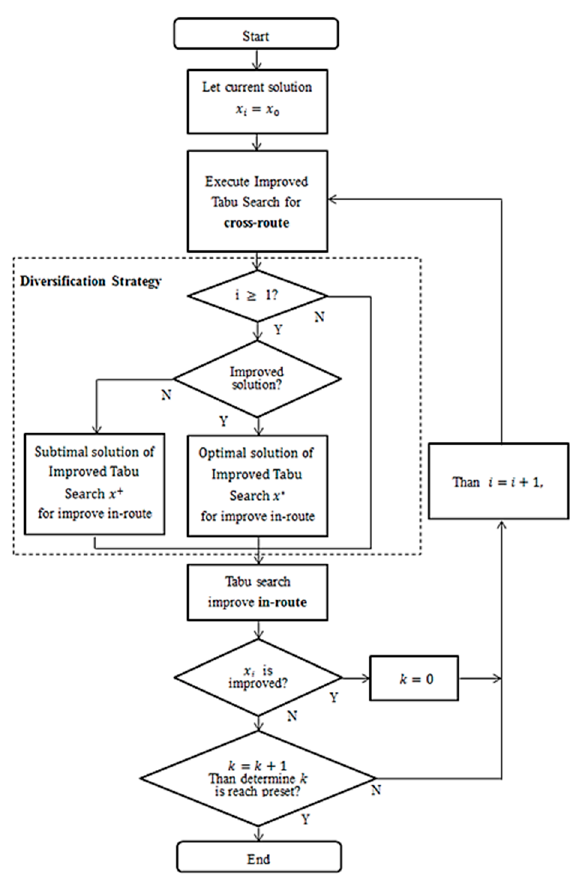
Figure 11. Flowchart of path improvement.